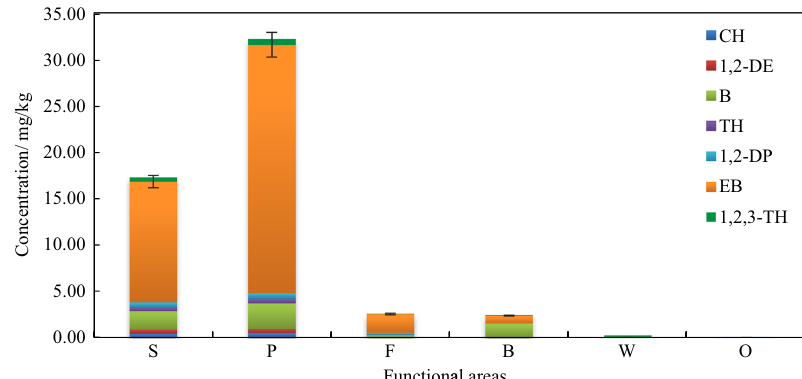
Figure 2: VOCs concentration distribution in each functional area across the chemical